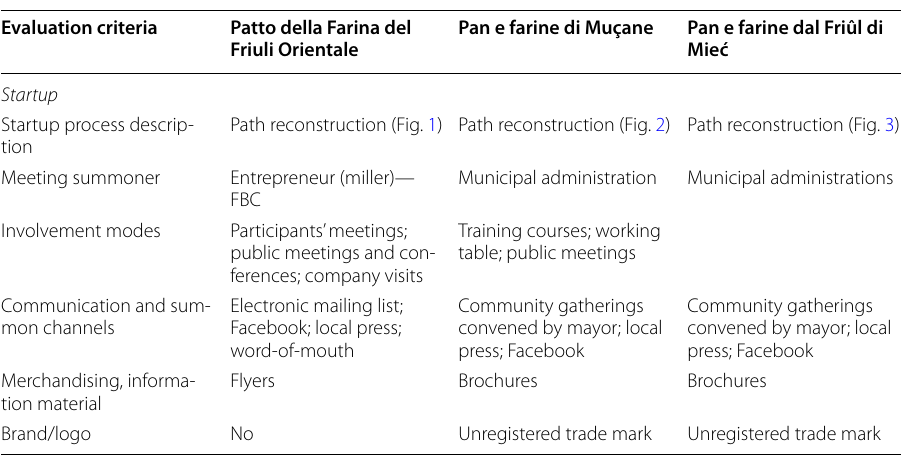
Table 2 Startup HOW Evaluation